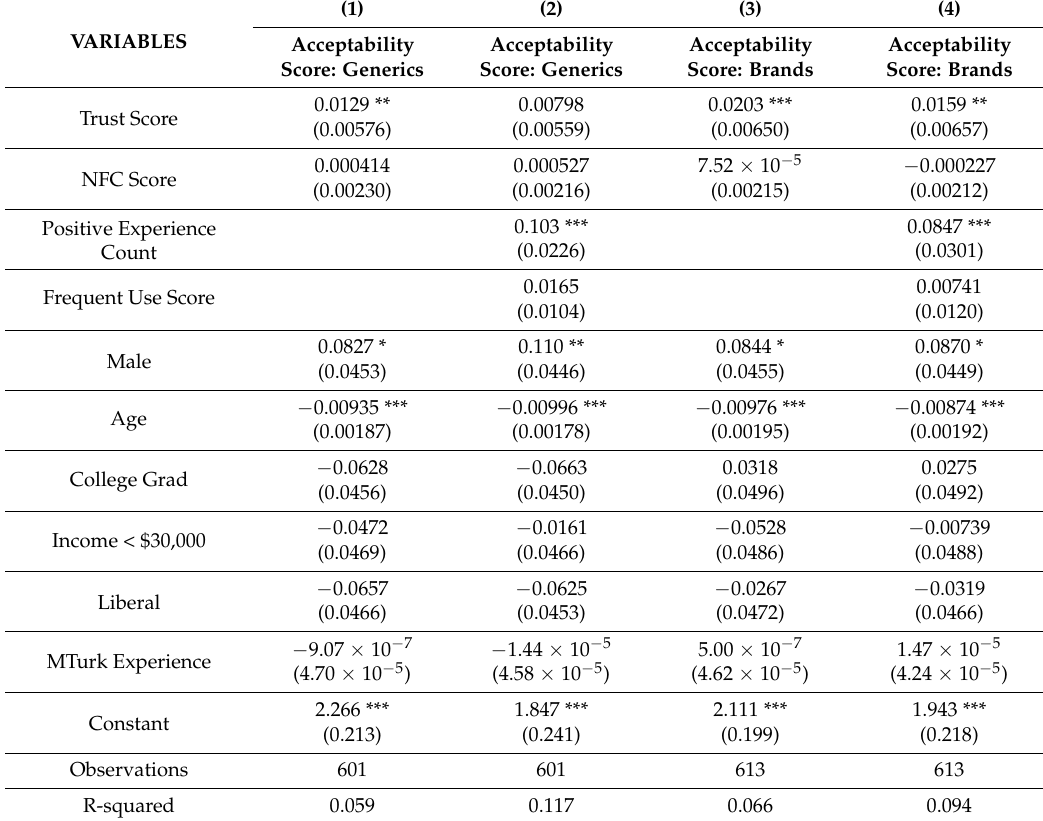
Table 6. Separate regressions for generic and brand